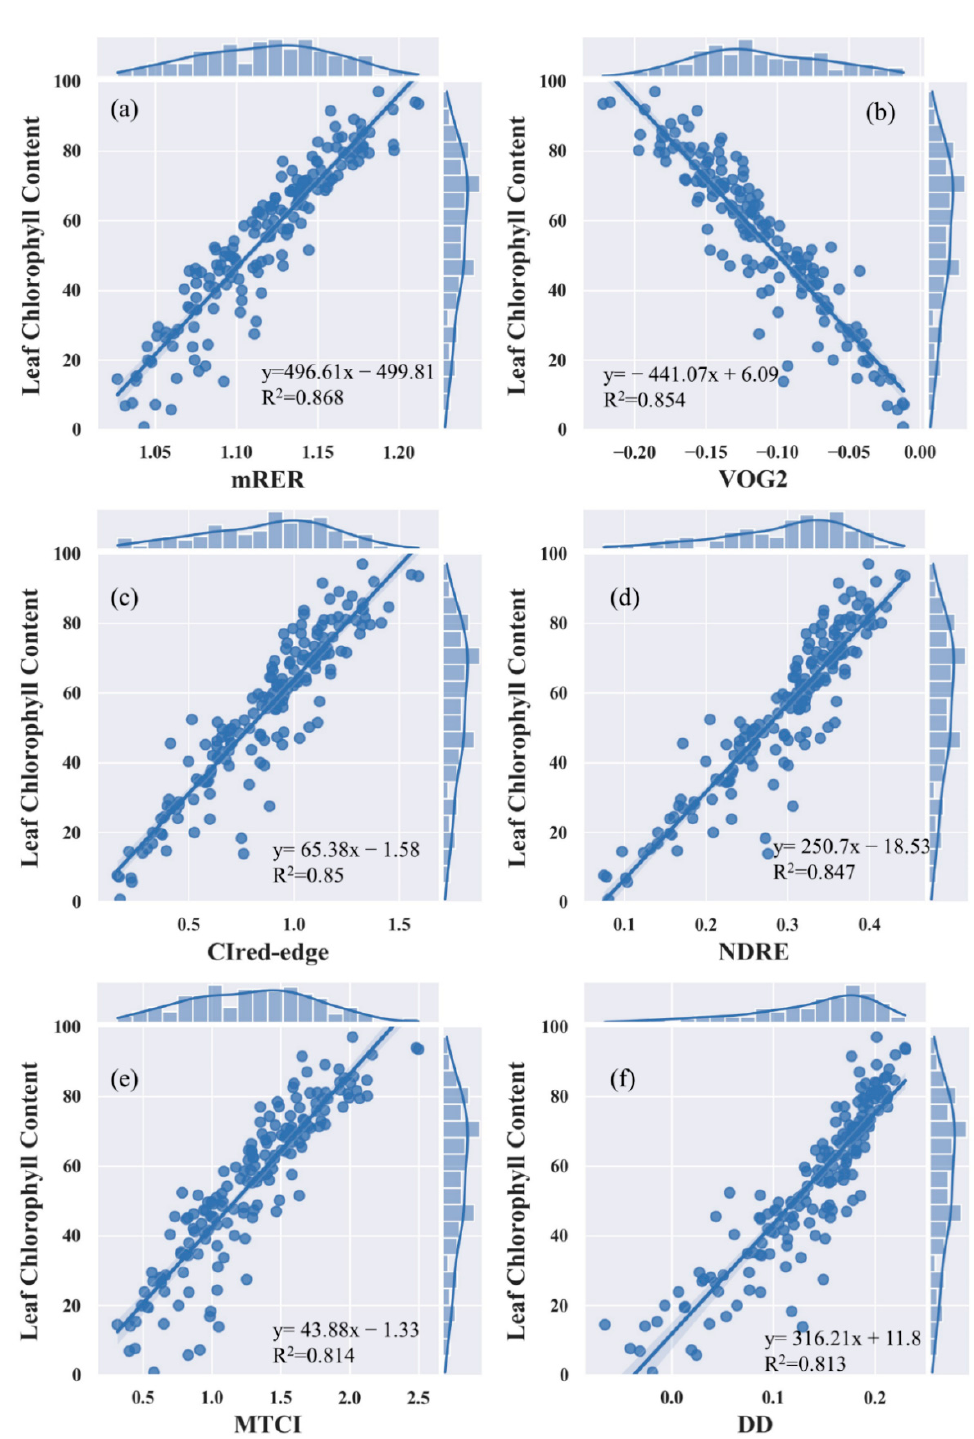
Figure 4. Relationship between LCC and six selected vegetation indices (VIs): ( a ) modified red-edge ratio (mRER), ( b ) Vogelman red edge index 2 (VOG2), ( c ) red edge chlorophyll index (CI red-edge ), ( d ) normalized difference red edge index (NDRE), ( e ) MERIS terrestrial chlorophyll index (MTCI), and ( f ) double difference index (DD). Linear models were built using the 2020 modeling dataset. Correlation coefficients and p -values are shown above each scatterplot, and the distributions of VI and LCC values are shown as histograms at the top and side of each graph,